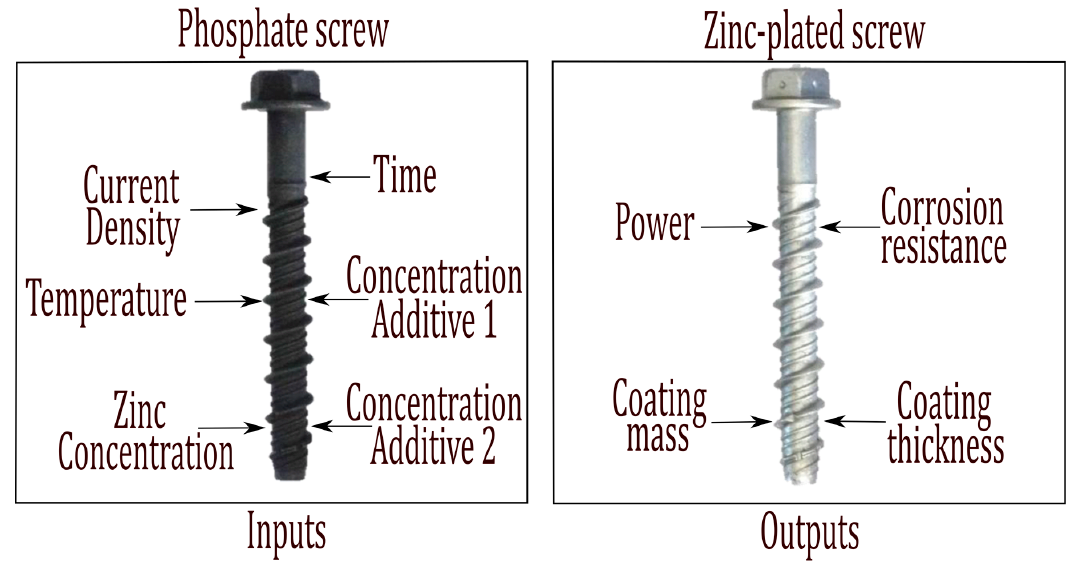
Figure 1. Inputs and outputs that were considered in this work for the modelling and optimizing of the zinc electroplating process of screws.